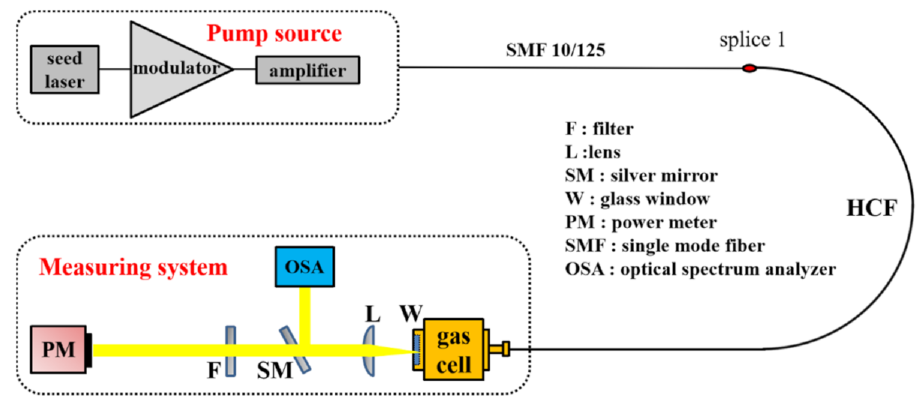
Figure 1. The experimental setup of the fiber gas Raman laser based on deuterium.